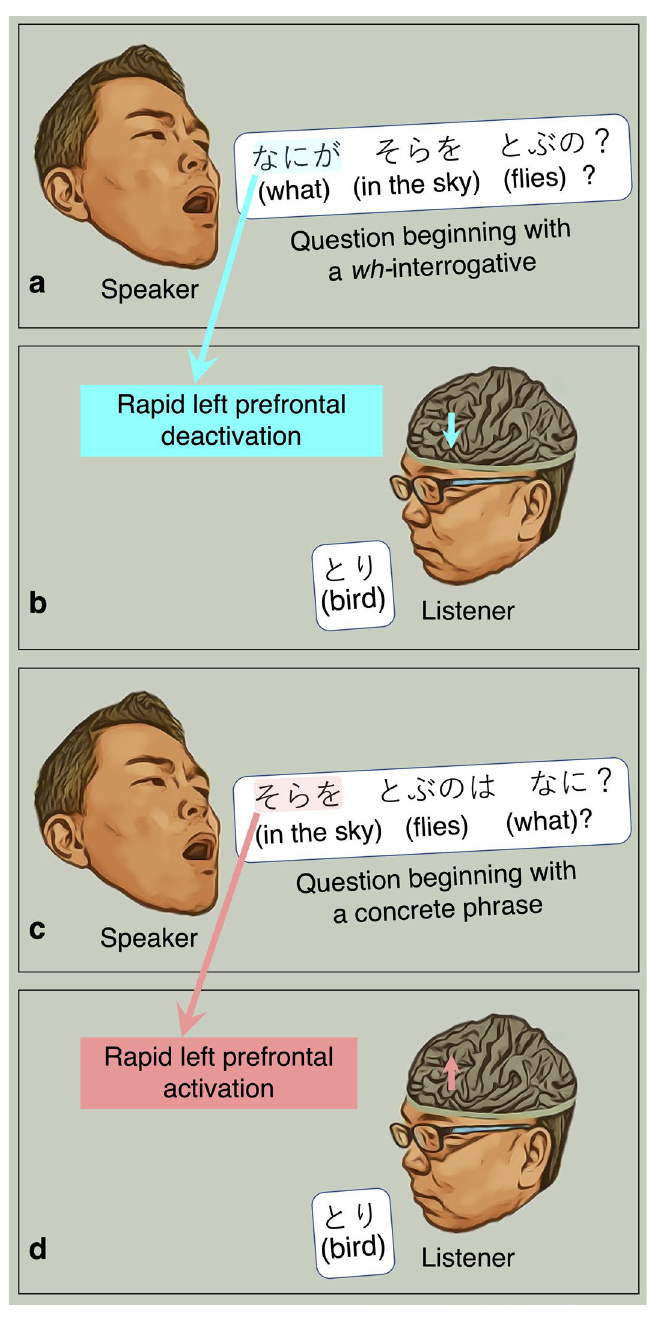
Figure 1. Four-frame cartoon summarizing the results of the present study. ( a ) and ( b ) The present study will demonstrate that verbal questions beginning with a wh- interrogative deactivate the left posterior prefrontal regions immediately after the 1st phrase offset. ( c ) and ( d ) Conversely, those beginning with a concrete word activate the left posterior prefrontal regions immediately after the 1st phrase offset. It should be noted that an adposition follows a noun in Japanese but precedes in